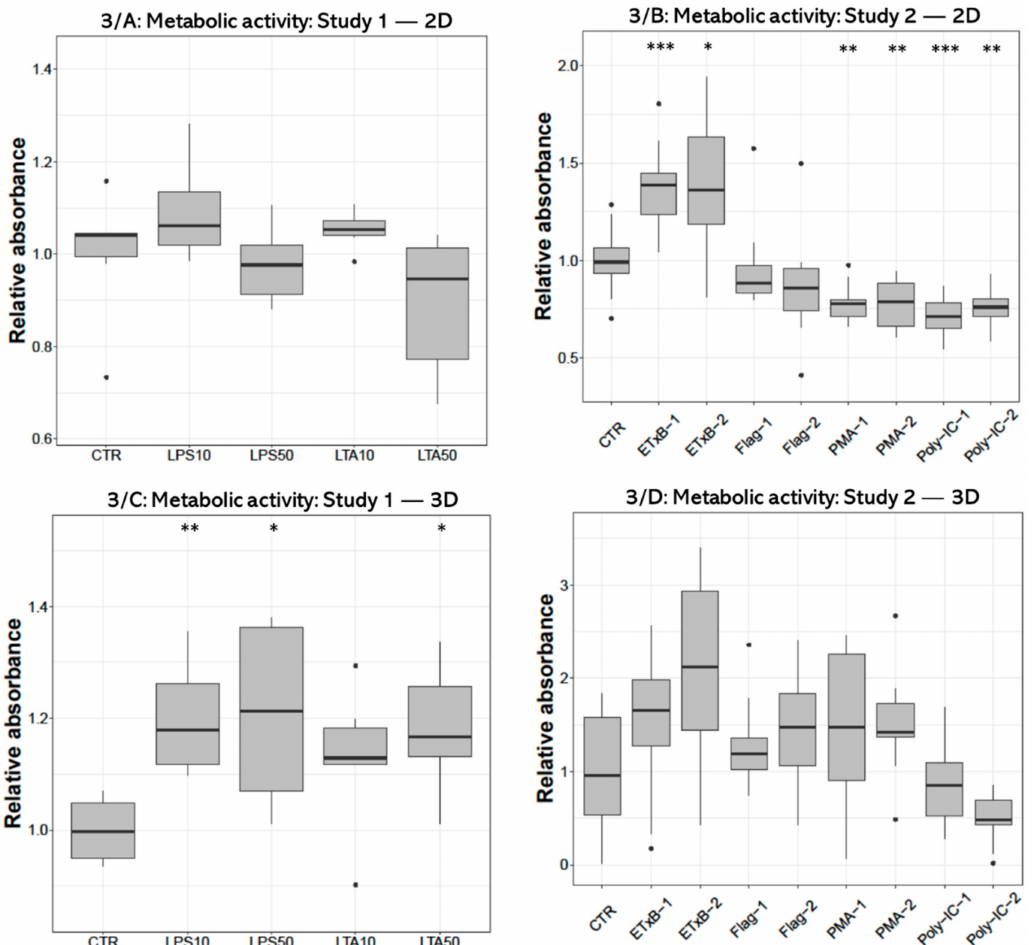
Figure 3. Boxplots showing the metabolic activity of hepatocyte—non-parenchymal cells in 2D (Study 1: ( A ) and Study 2: ( B )) and 3D (Study 1: ( C ) and Study 2: ( D )) co-cultures indicated by the CCK-8 assay (n study 1 = 6/group, n study 2 = 10/group). Relative absorbances were calculated by considering the mean value of control cultures as 1. The “CTR” refers to control cells that received none of the treatments. The treatments were: LPS10 and LPS50 = 10 and 50 µ g/mL lipopolysaccharide (LPS) from Escherichia coli , LTA10 and LTA50 = 10 and 50 µ g/mL lipoteichoic acid (LTA) from Staphylococcus aureus , ETxB-1 and -2 = 20 and 50 µ g/mL subunit B of heat-labile enterotoxin of Escherichia coli , Flag-1 and -2 = 100 and 250 ng/mL flagellin from Salmonella Typhimurium, PMA-1 and -2 = 100 and 1000 ng/mL phorbol myristate acetate (PMA), poly-IC-1 and -2 = 50 and 100 µ g/mL polyinosinic polycytidylic acid (poly I:C). Asterisks over the boxes refer to significant differences compared to “CTR” cells within the same cell culture model and the same study. * p < 0.05, ** p < 0.01, *** p <